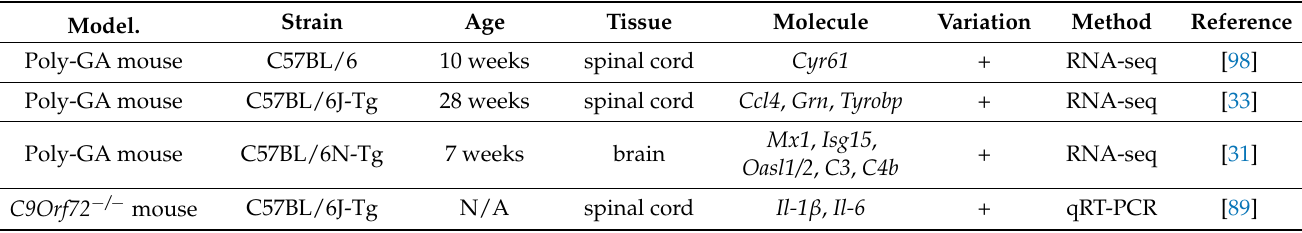
Table 3. Microglial alterations in C9Orf72 mice based on the age, collected tissue and method.